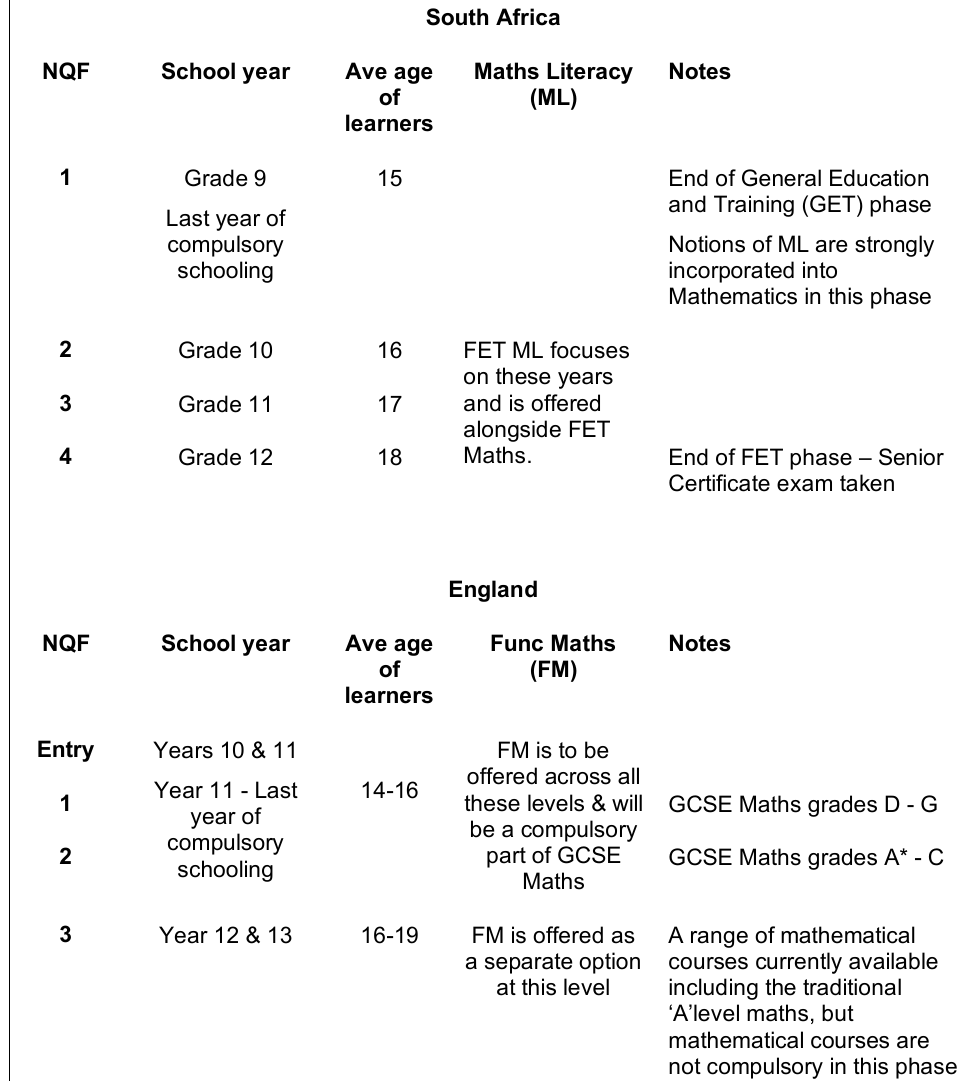
Table 1 : Schooling and qualification structures - senior phase in South Africa and